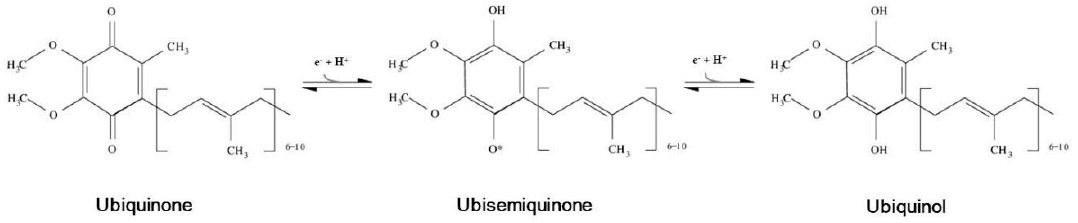
Figure 1. Alternative redox forms of Coenzyme Q.